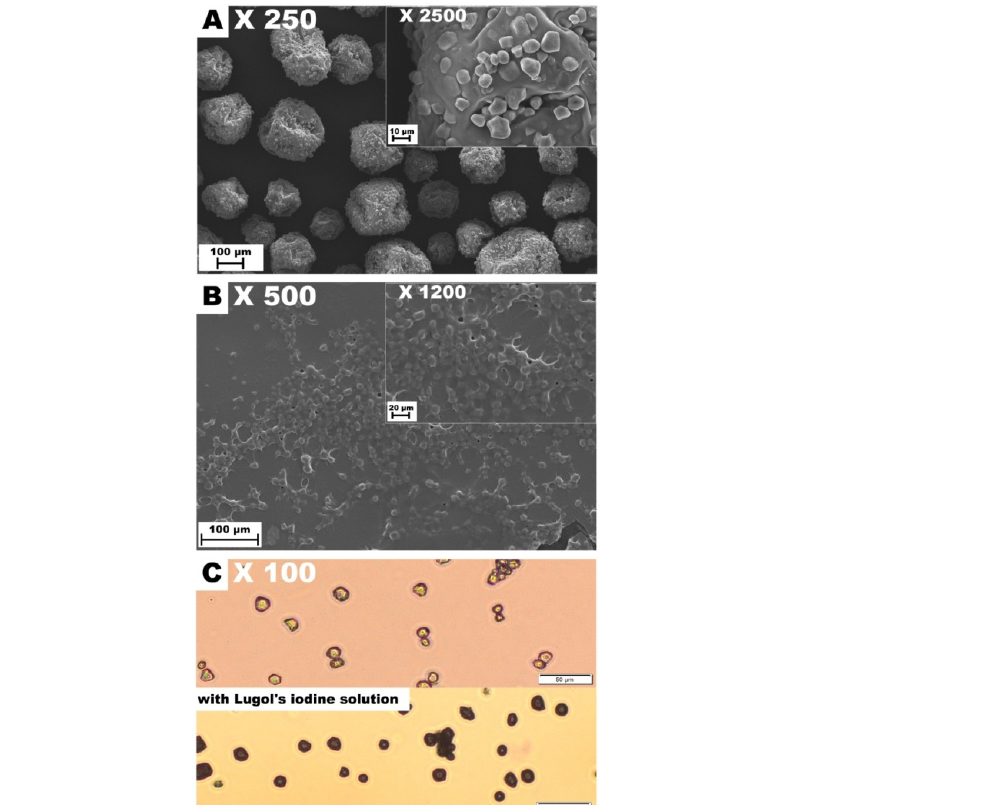
Figure 1. SEM images of the surfaces of the AST-free and 1%AST-added binary blend films based on polysaccharides (CMC, GAR, OSA and WSSP) and gelatin (GEL).